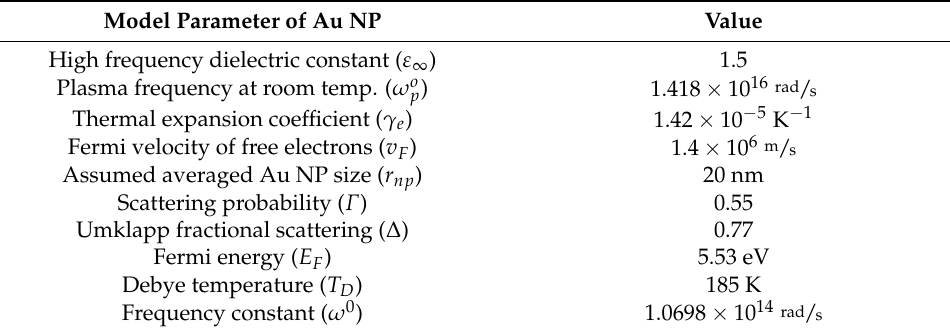
Table 1. Model parameters used to generate optical constants and dielectric functions of Au nano particles in Figure